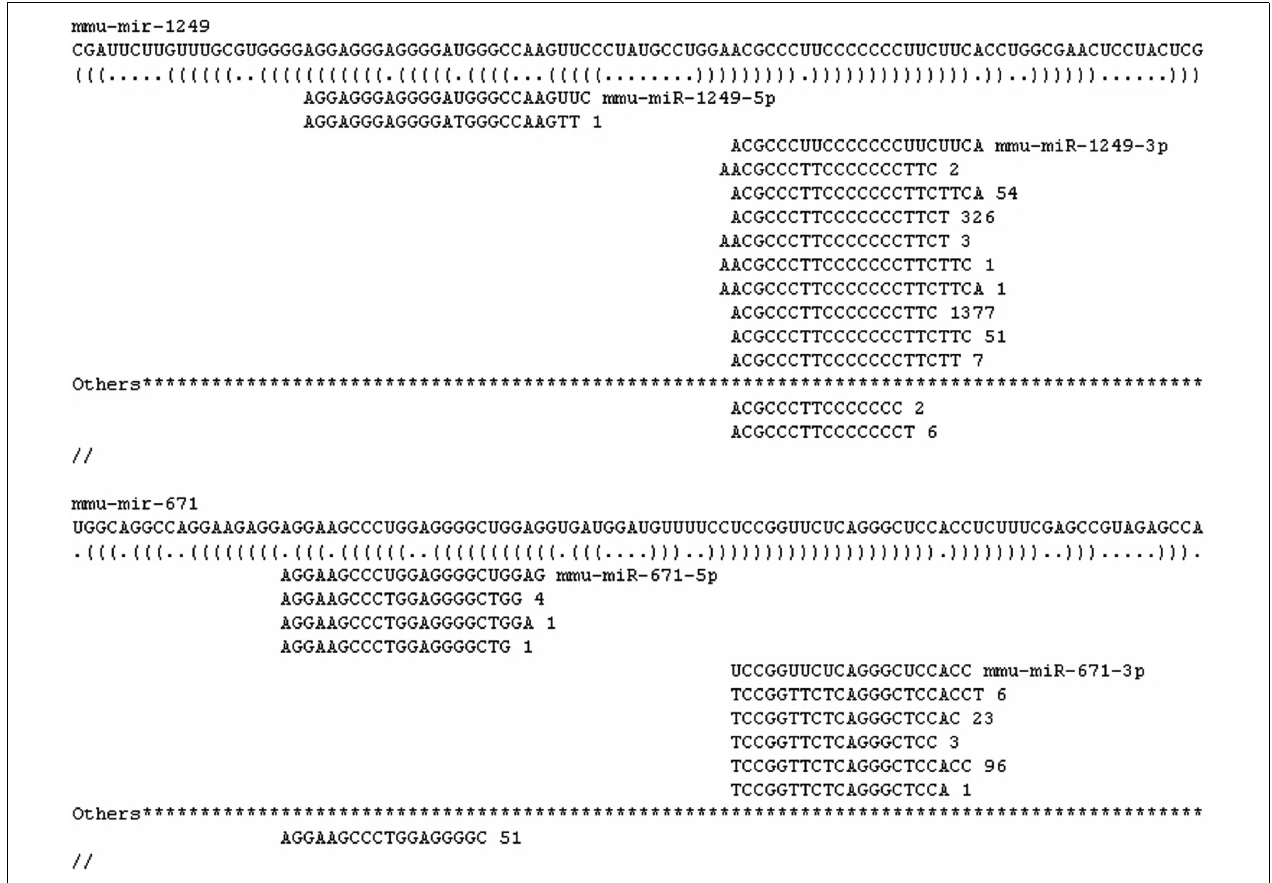
FIGURE 1 | Screen shot of miRExpress output. Example of mature miRNA and isomiR alignment to a precursor miRNA.